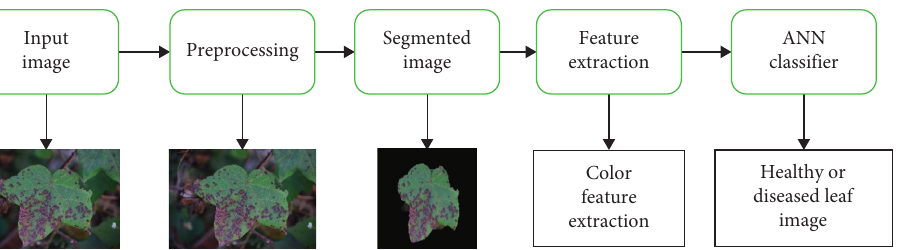
Figure 4: Proposed model.